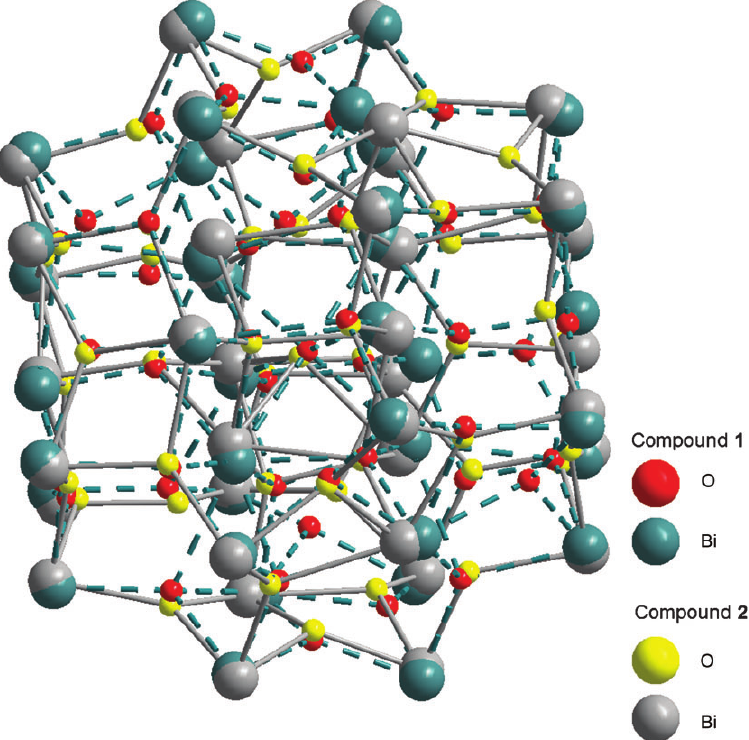
Figure 6 Comparison of the [Bi